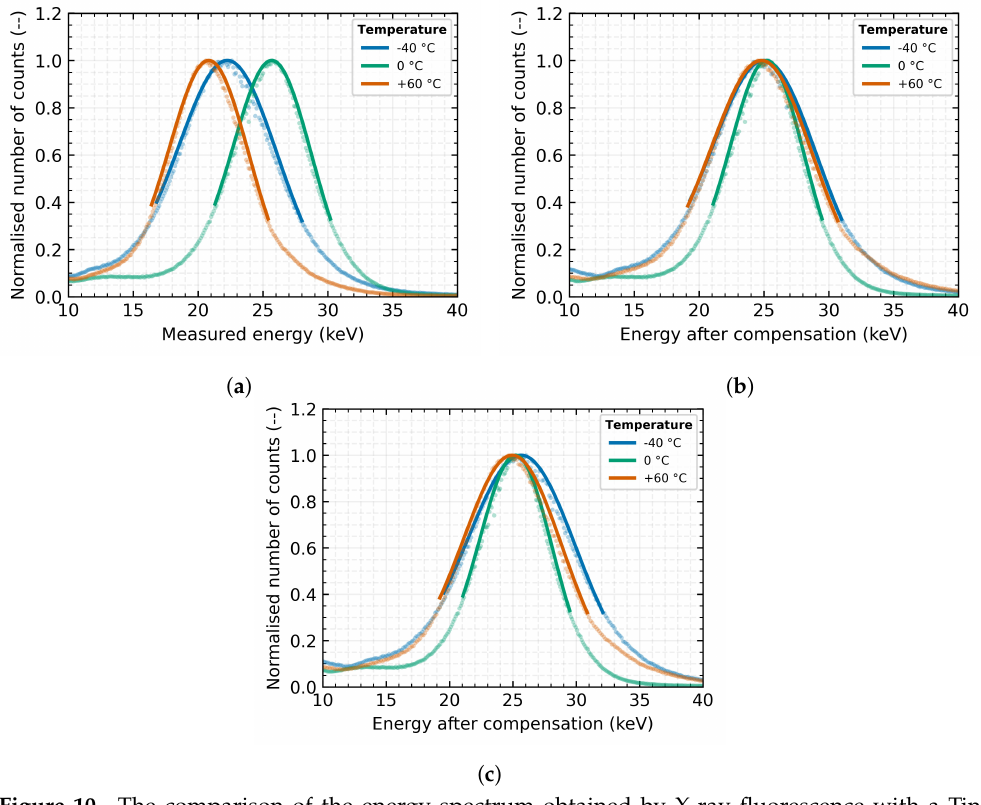
Figure 10. The comparison of the energy spectrum obtained by X-ray fluorescence with a Tin target and different compensation for thermal distortion. The measurement results of a detector with a 1000µm Si sensor placed in a vacuum for different sensor temperatures ( 60°C) are shown: ( a ) Without compensation; ( b ) Individual compensation model; ( c ) Extrapolated compensation